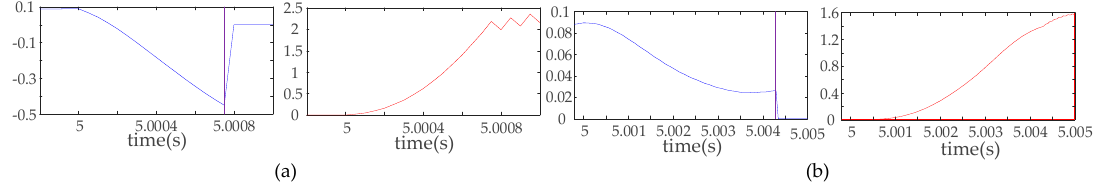
Figure 10. External pole-to-ground faults for VSC protection. ( a ) A 3 Ω transient resistance; ( b ) a 5 Ω transient resistance.